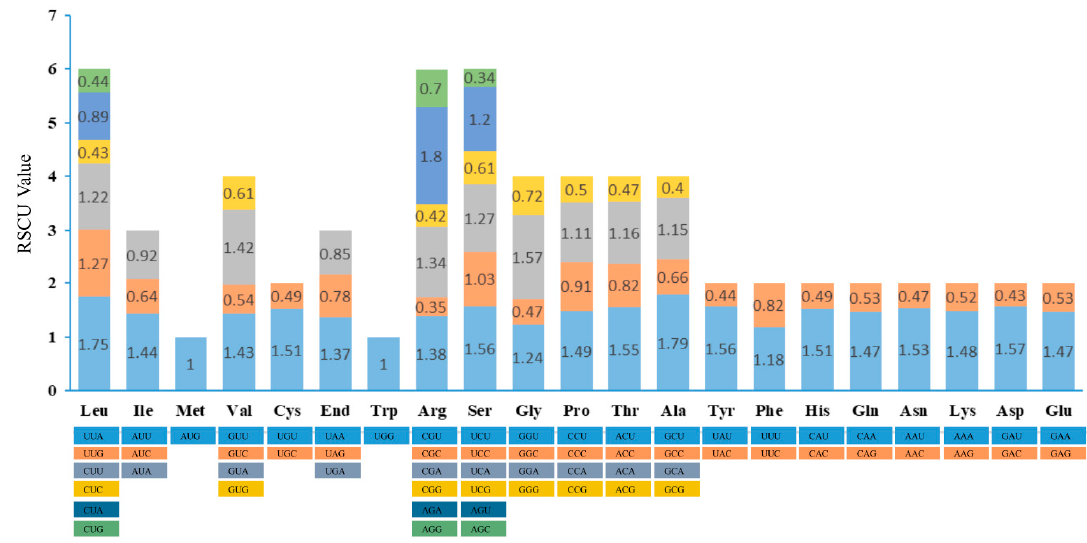
Figure 3. RSCU value of 20 amino acids and stop codons in all protein-coding genes of M. chuanchienensis chloroplast genome.